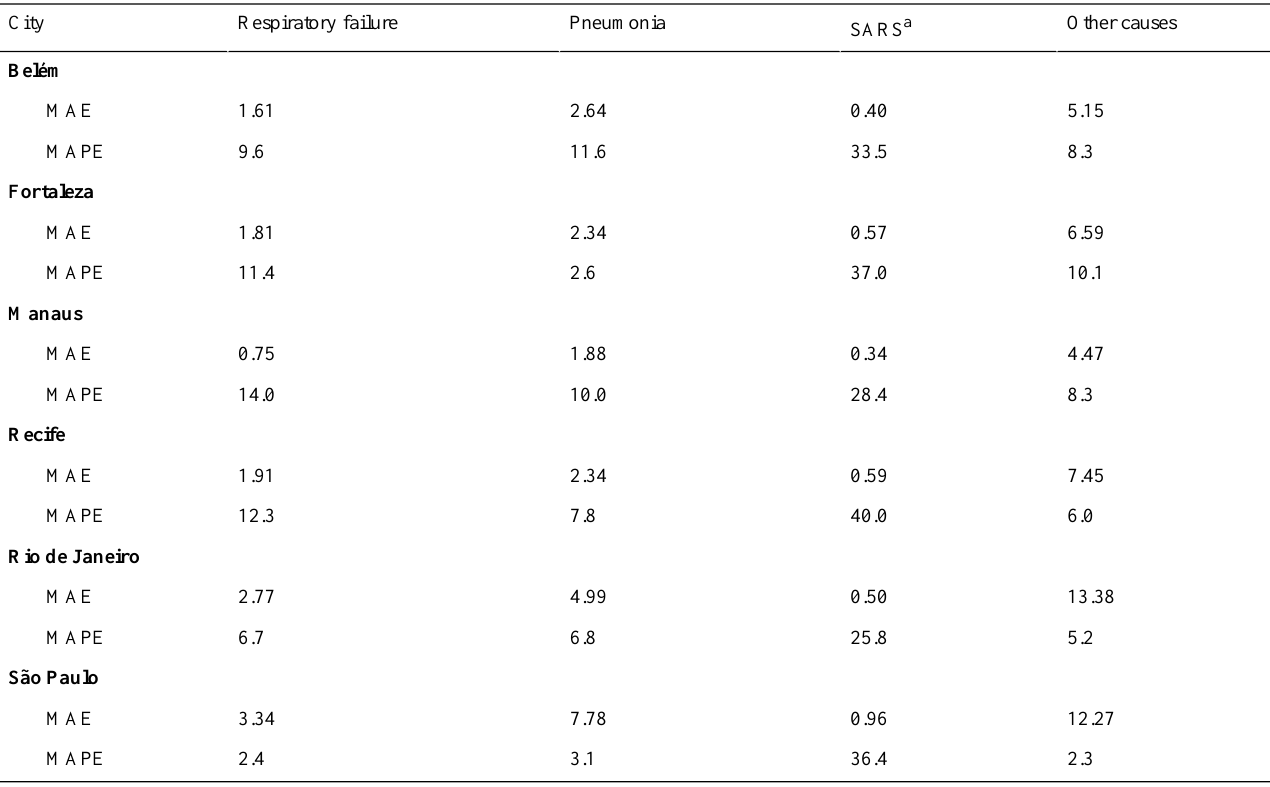
Table 4. Mean absolute error (MAE) and mean absolute percentage error